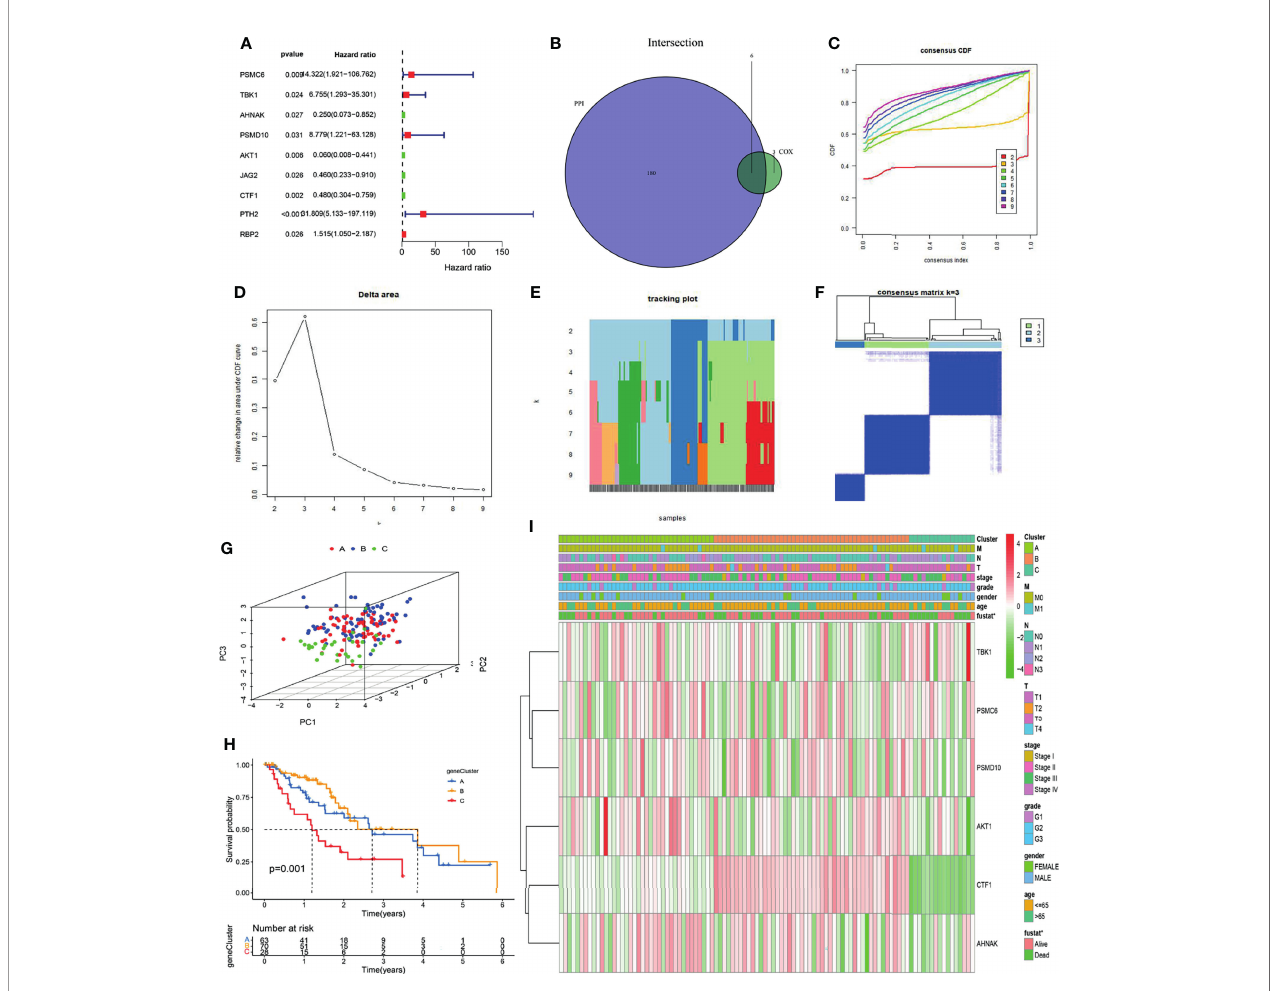
FIGURE 5 | Six immune genes were screened and tumors were classi fi ed into three immune subtypes. (A) Using univariate Cox analysis, 9 immunological genes associated with prognosis were identi fi ed. (B) The intersection between 180 PPI network core genes and 9 immune genes was selected, and 6 immune genes were screened. (C – F) Based on 6 immune genes, ESCC could be classi fi ed into three immune subtypes by consensus clustering analysis. (G) Principal component analysis (PCA) showed that the tumors were well typed. (H) OS analysis of patients with different subtypes ( P = 0.001). (I) Gene expression analysis and clinical correlation analysis of different subtypes (* P <